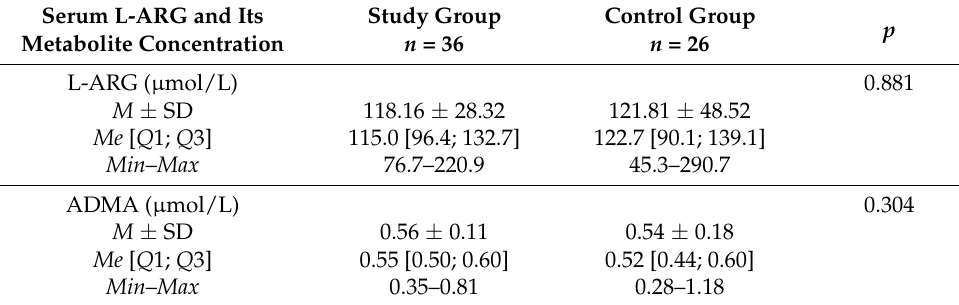
Table 3. Serum concentrations of L-ARG and its